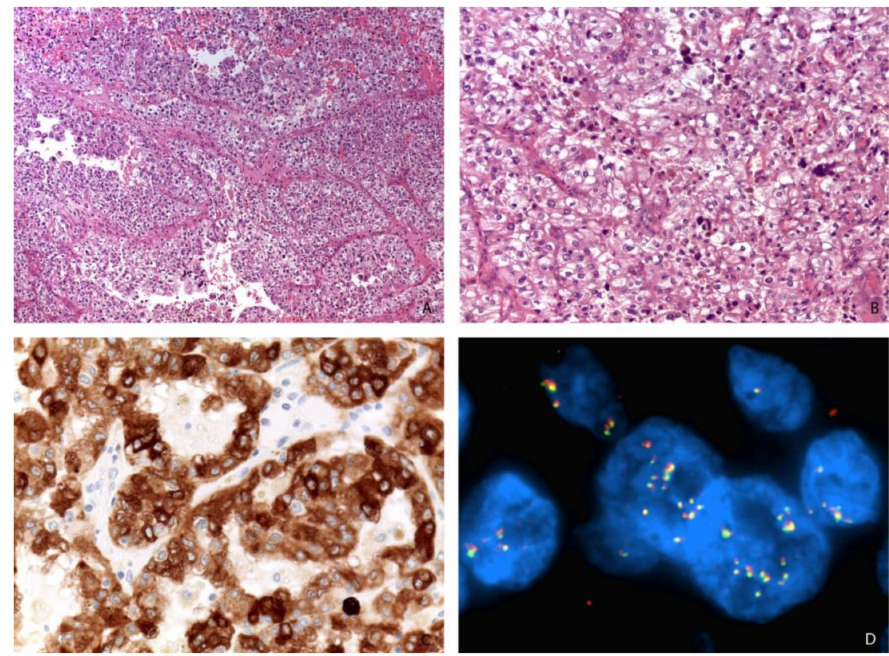
Figure 4. A high-grade renal cell carcinoma ( A , Magnification: 50 × ; B , Magnification: 200 × ) expressing Melan-A (Magnification: 400 × ) ( C ) and showing TFEB gene amplification by FISH (Magnification: 1000 × ) ( D ).